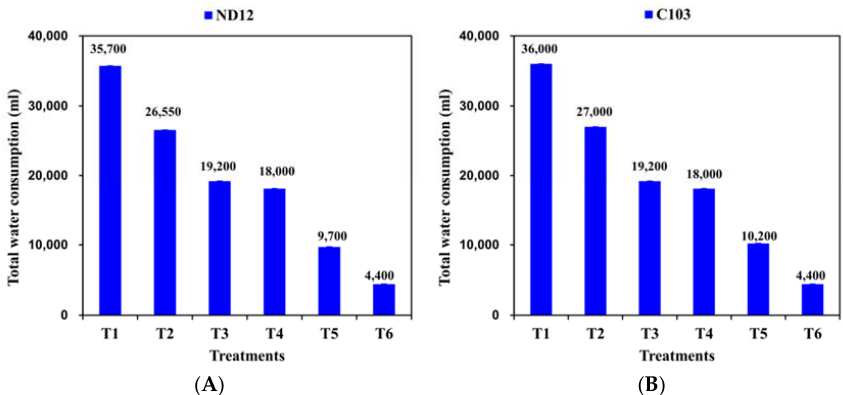
Figure 2. The total water consumption under different split ‐ root water imbalance treatments (mL). ND12 (drought resistant) ( A ) and C103 (drought susceptible) ( B ). T1, 100/100; T2, 100/50; T3, 100/20; T4, 50/50; T5, 50/20; T6, 20/20.